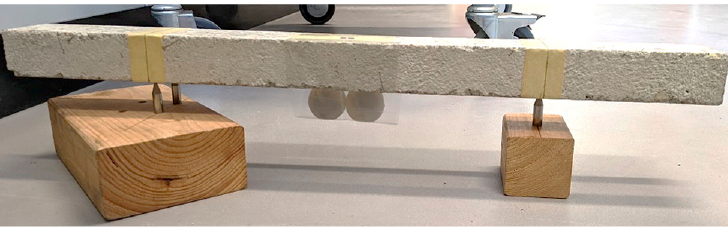
Figure 7. Point-Supporting the Beam in the Lab.